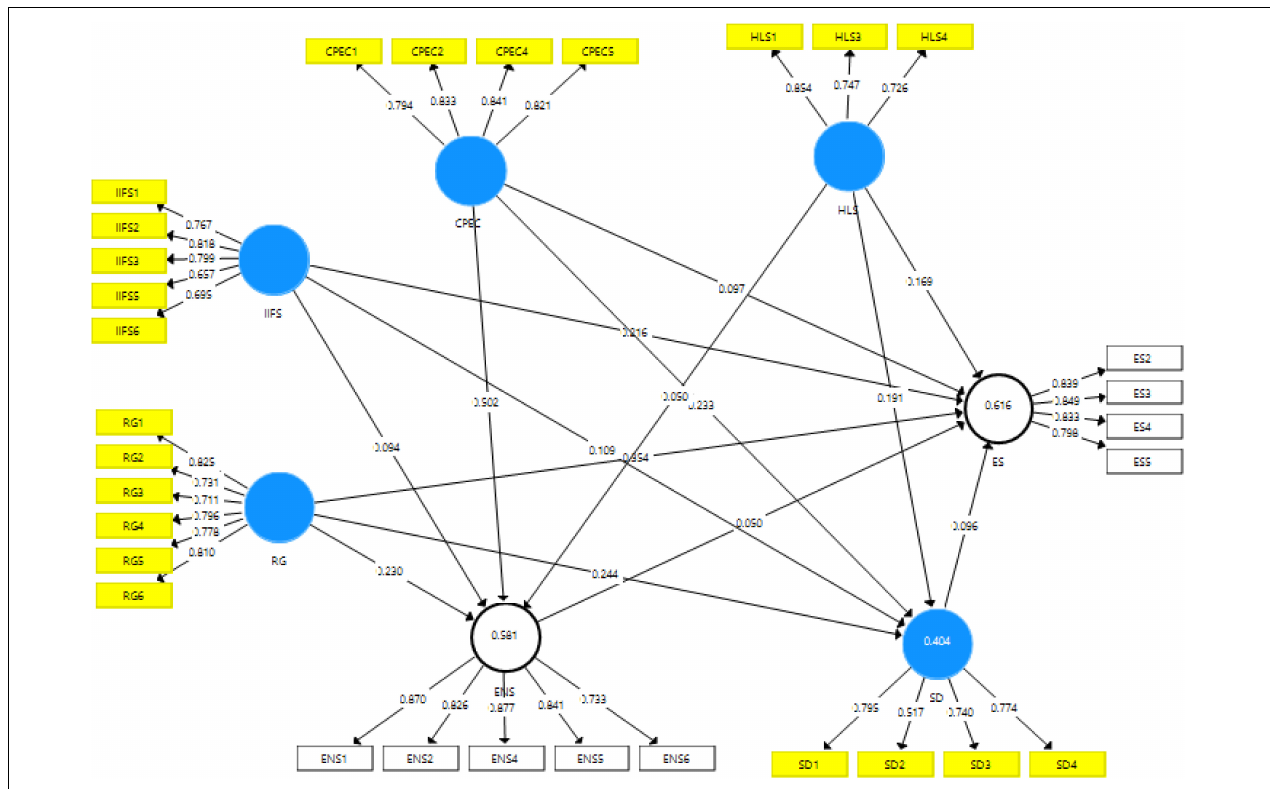
FIGURE 2 | Measurement model